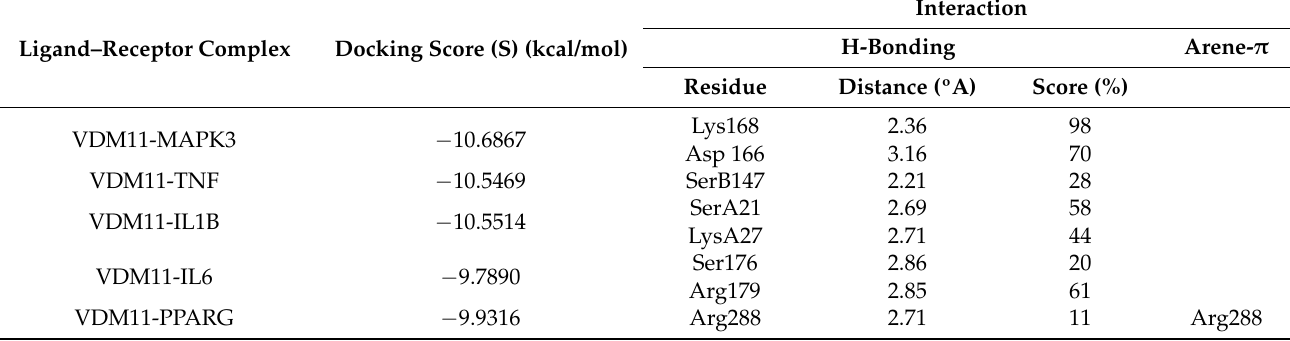
Table 1. Binding mode analysis of VDM11 with selected targets.